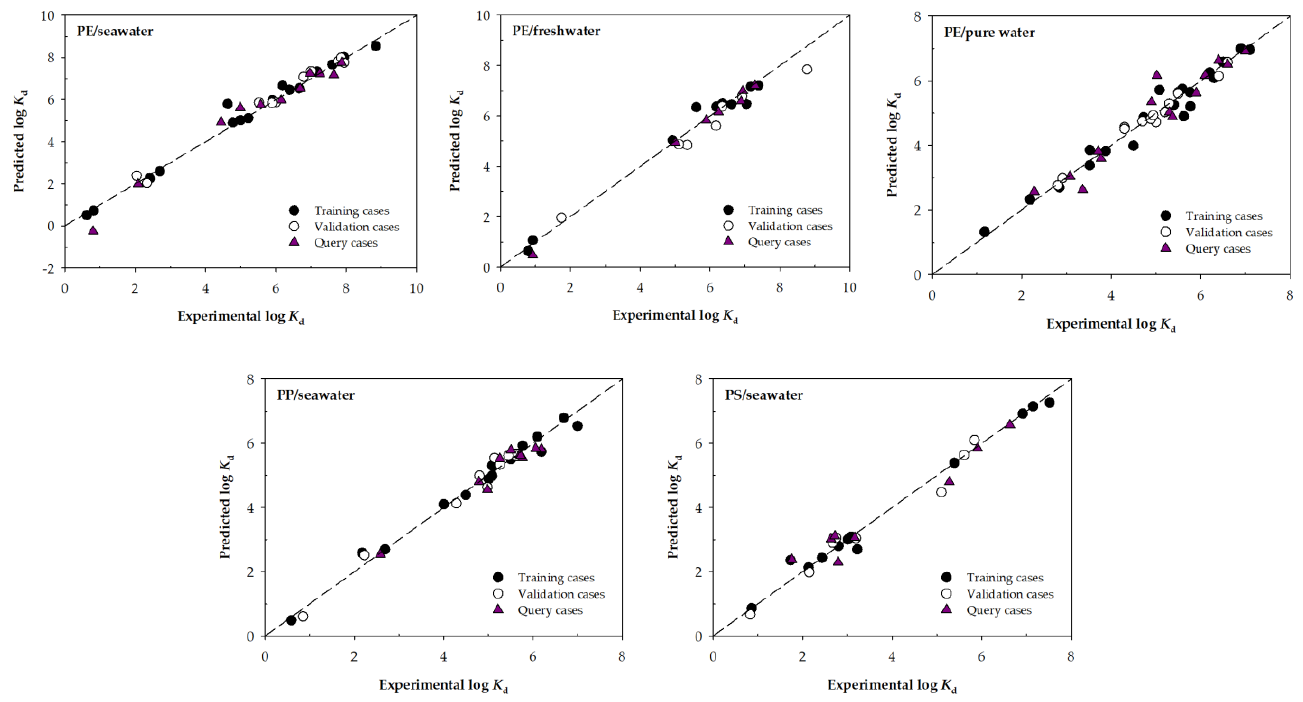
Figure 2. Scatter plots for the experimental and predicted values of log K d for the selected ML models developed using the input variables selection Type 2. The dashed line corresponds to the line with slope 1.